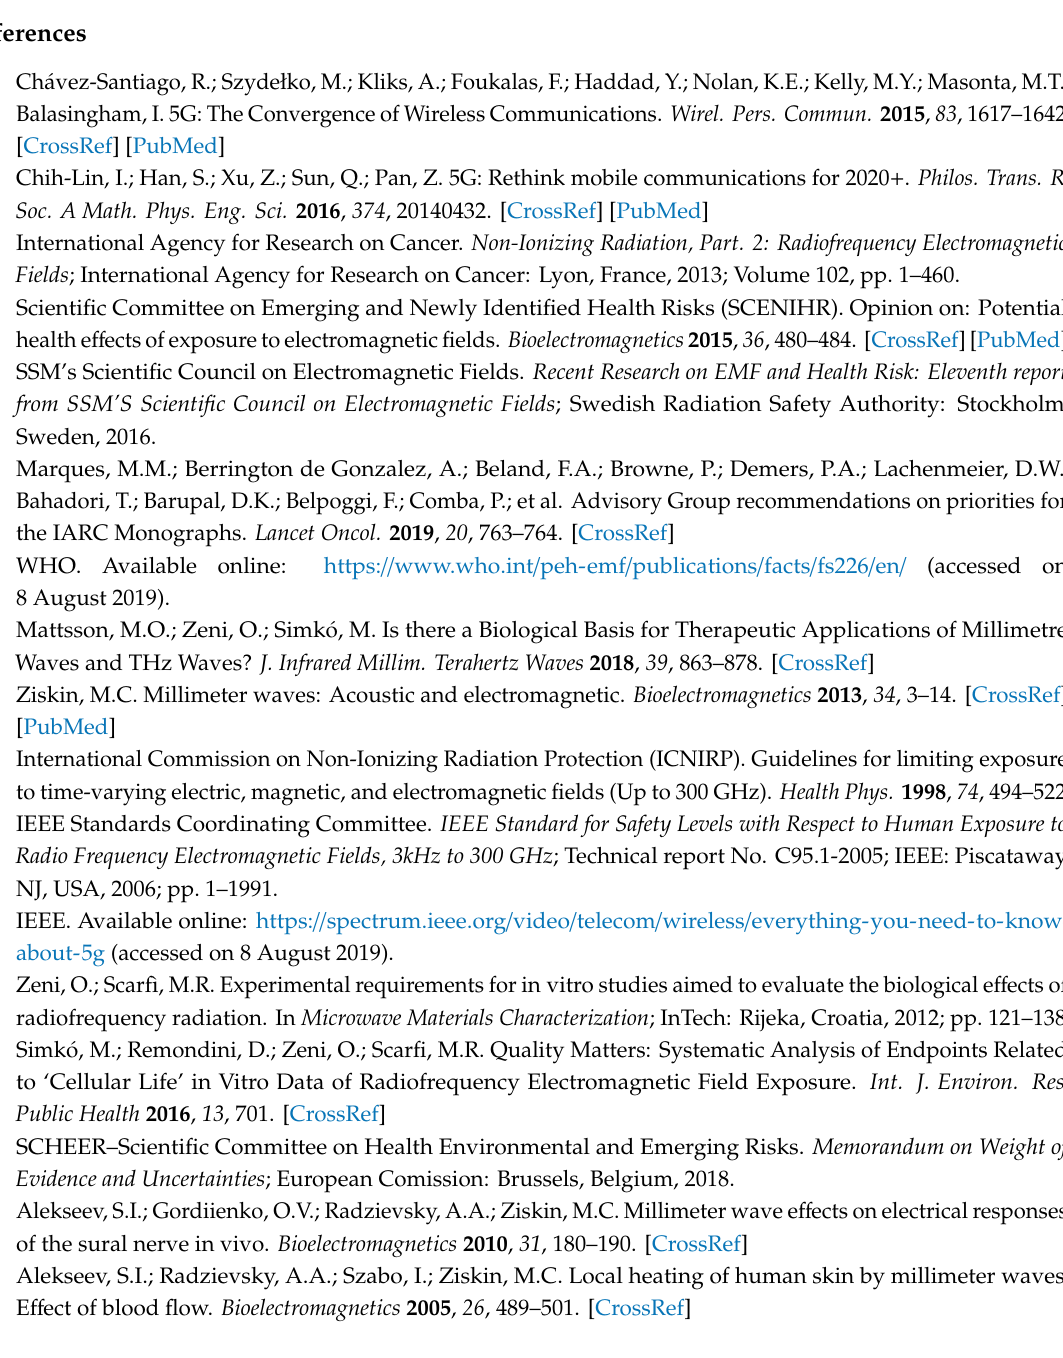
Table S1: Master-table of the selected (in vivo and in vitro) studies and the extracted physical, biological, and quality